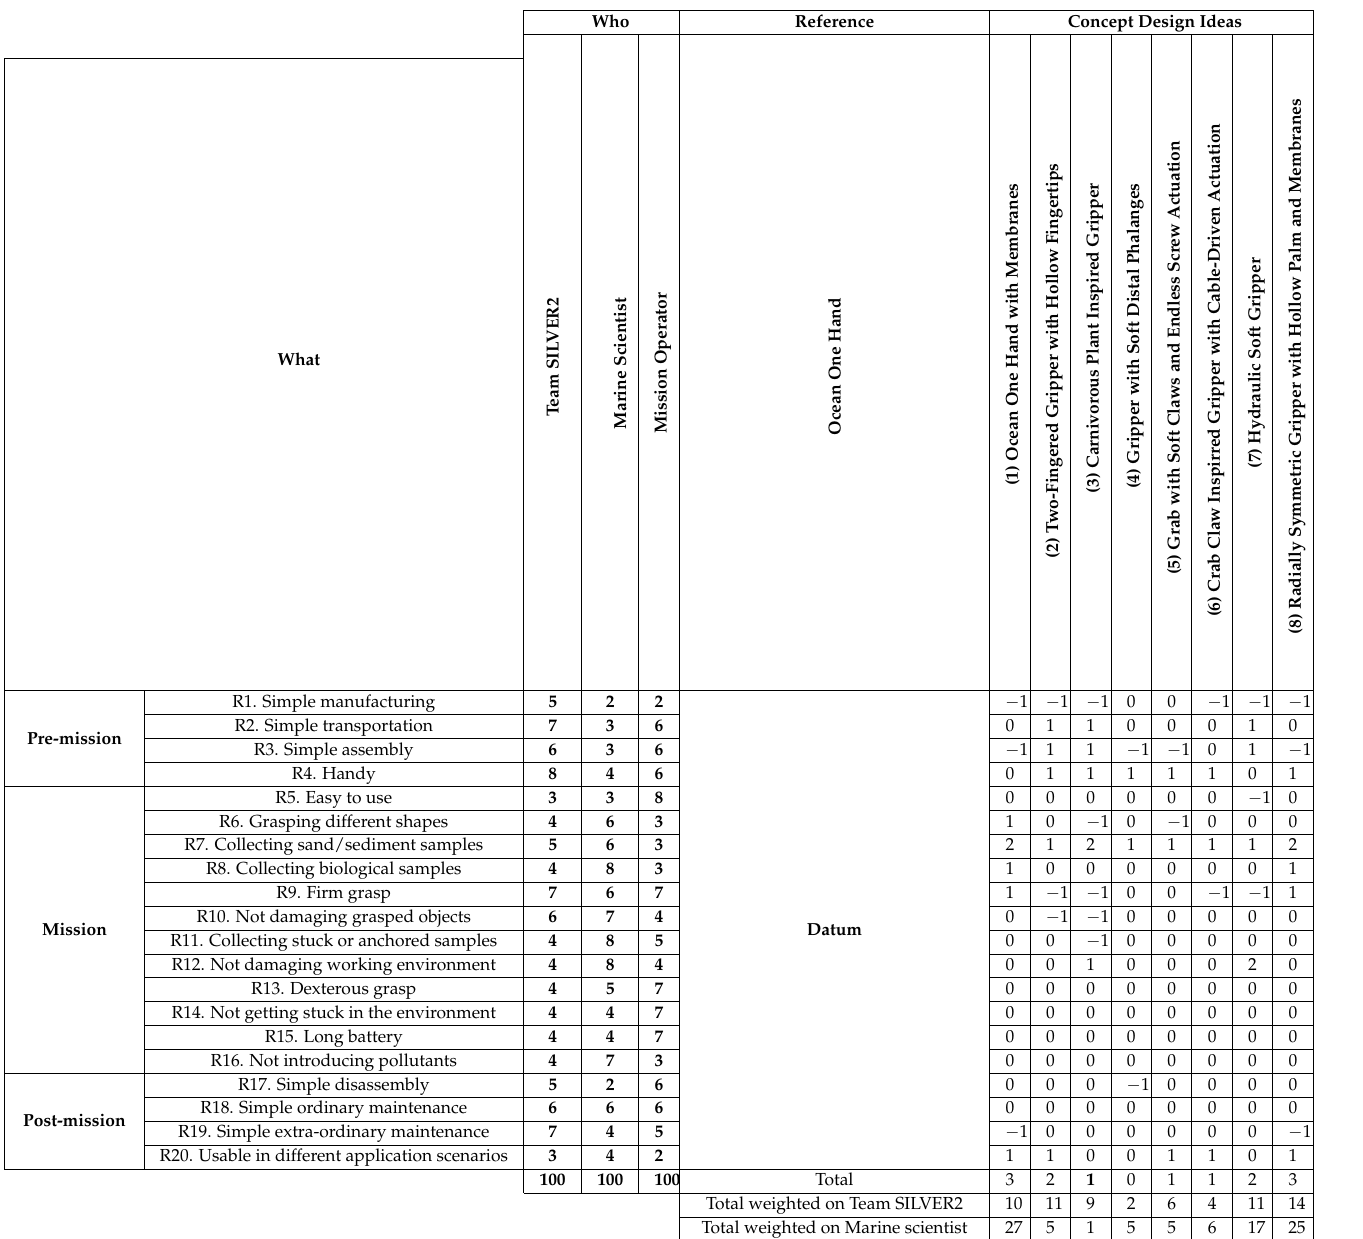
Table 3. Decision matrix for the design of the underwater gripper presented in this work. The concept design ideas are evaluated with respect to a reference design, then weighted using the stakeholders ratings, which reflect the relative importance of individual requirements. The final score is obtained by summing the totals weighted for all